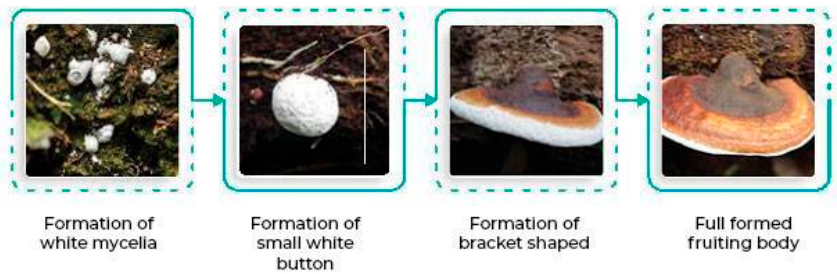
Figure 1. Development of the Ganoderma fruiting body. Ganoderma boninense is indicated through basidiocarps that are large, chronic, woody brackets that are lignicolous, leathery, and occasionally with a stem. The form of fruit bodies usually grows in a fan-or-hoof-like form on the tree trunks. They also have double- walled, truncated spores with yellowish to brownish ornamented inner layers. One of the justifications for why the disease has not been well detected beforehand is due to